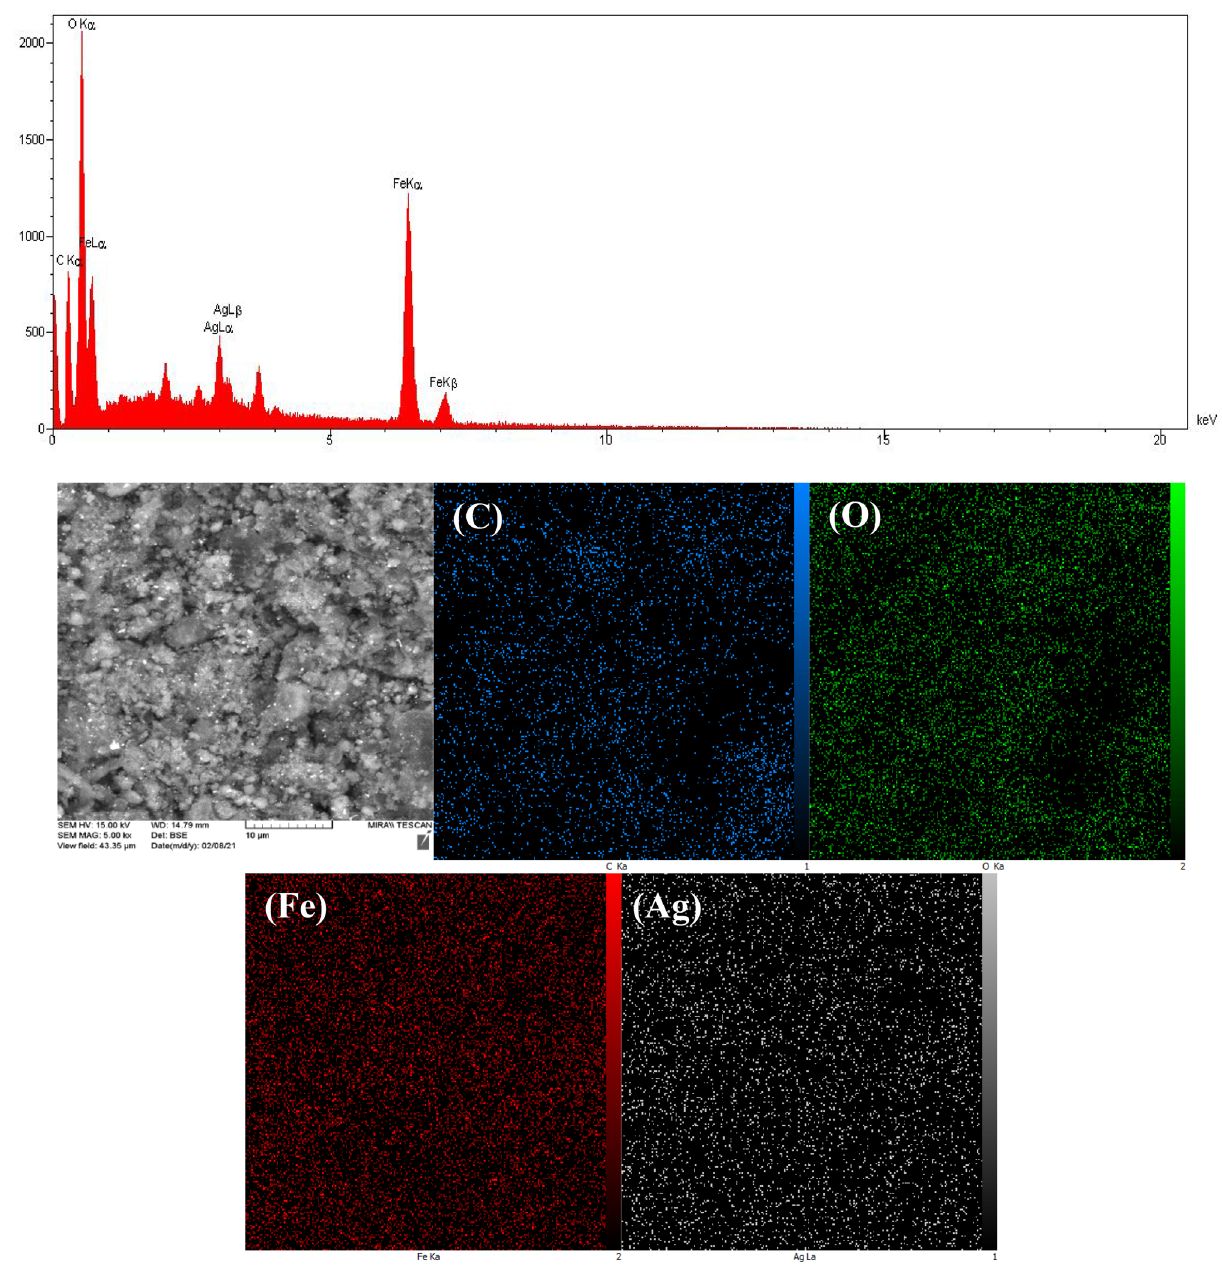
Figure 3. EDX-mapping analysis of biochar/Fe 3 O 4 –Ag